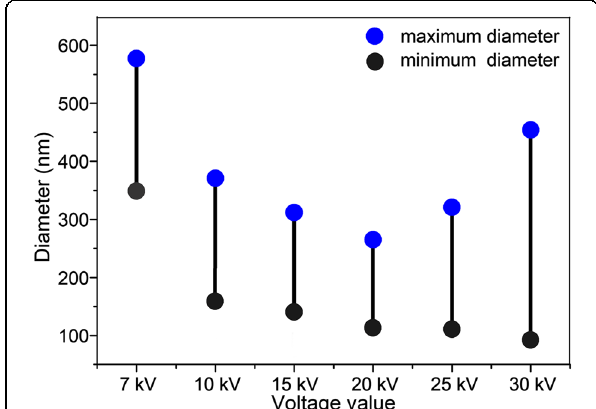
Fig. 9 The diameter distribution of PVA nanofiber under different voltage